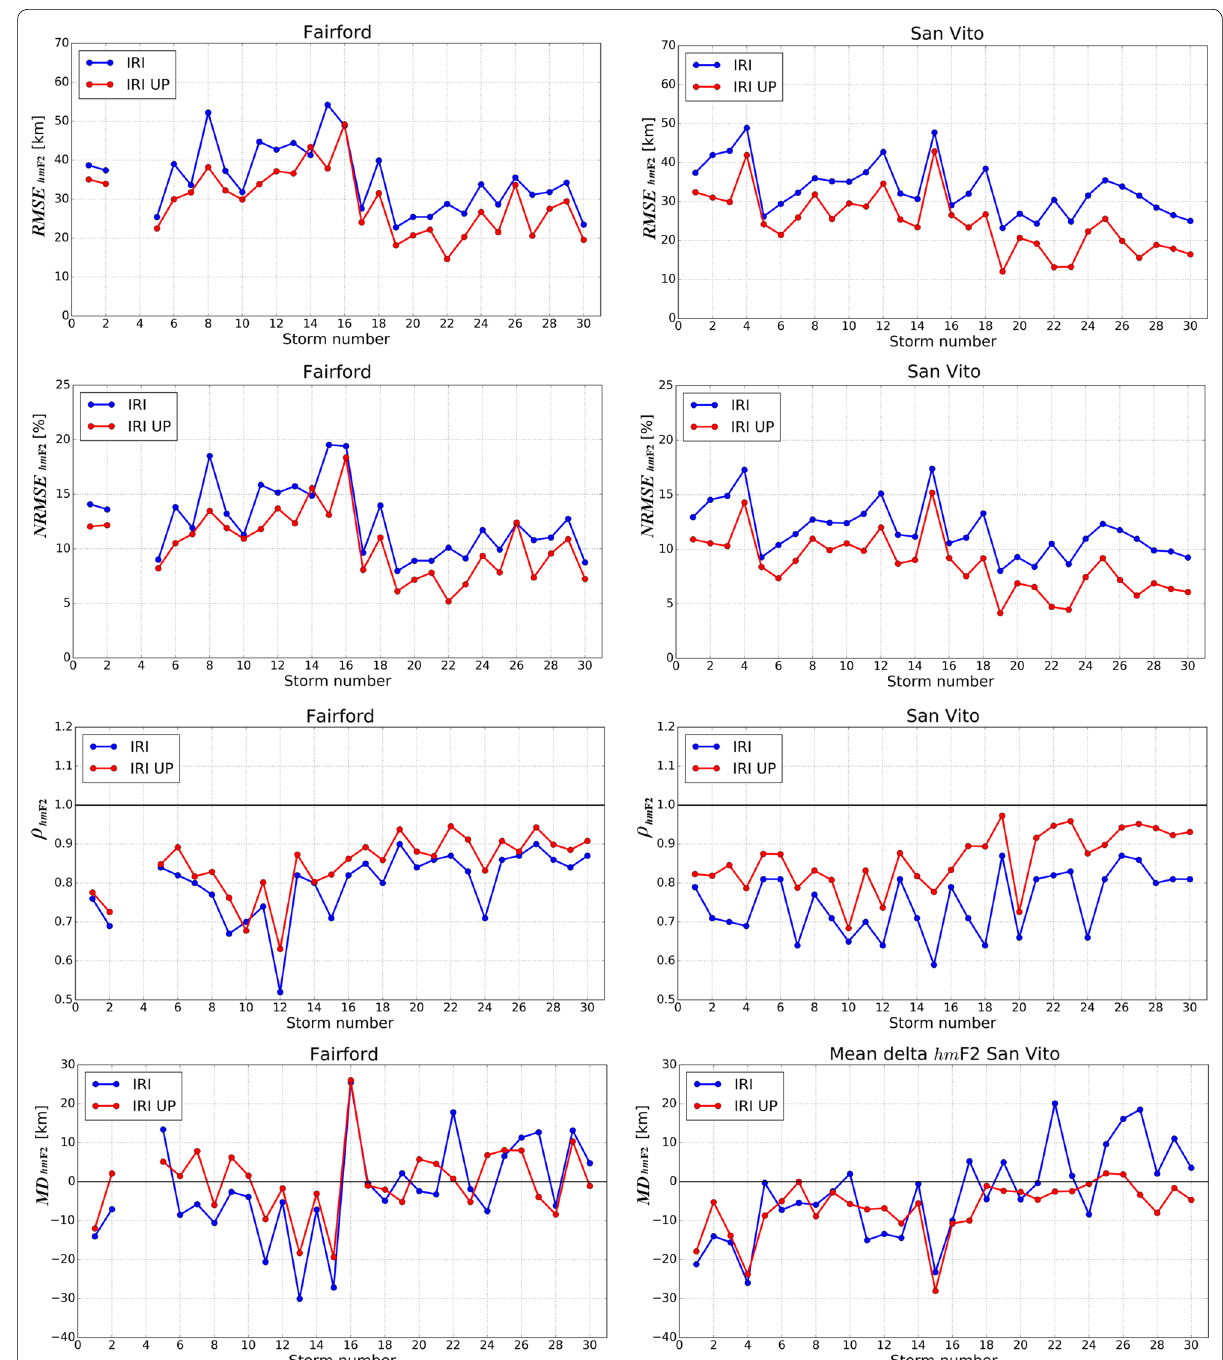
Fig. 11 Statistical parameters calculated at testing stations for hm F2, for each storm time period. Same as Fig. 10 but for hm